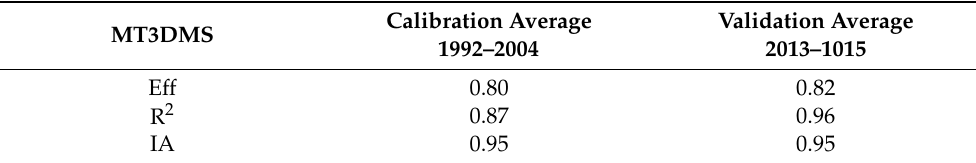
Table 10. Summary efficiency statistics of the MT3DMS model.